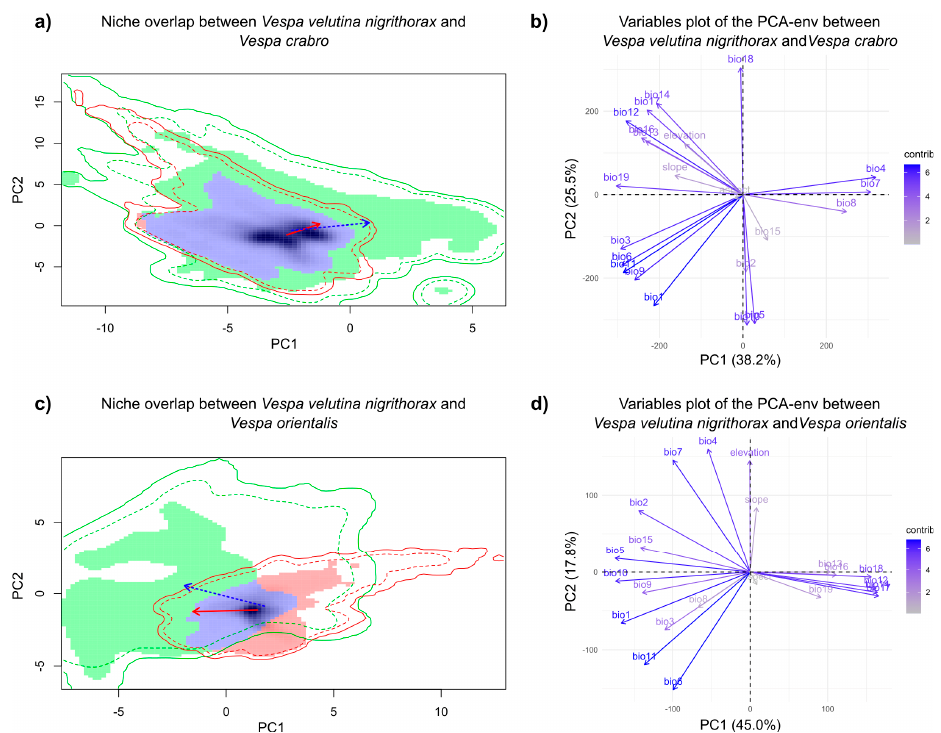
Figure 4. Results of the climatic niche analysis (PCA-env) at the study area level. ( a , c ) show the realised climatic niches of Vespa velutina nigrithorax (red) and the one of the two native species (green), respectively V. crabro and V. orientalis . Niche overlap is highlighted in blue. The solid and dashed contour lines illustrate, respectively, 100% and 50% of the available (background) environment. Arrows represent how the centre of the niche (red solid lines) and of the background (blue dashed line) change between species. ( b , d ) represent the variables plot of the PCA-env analysis along the first two principal components (PC1 and